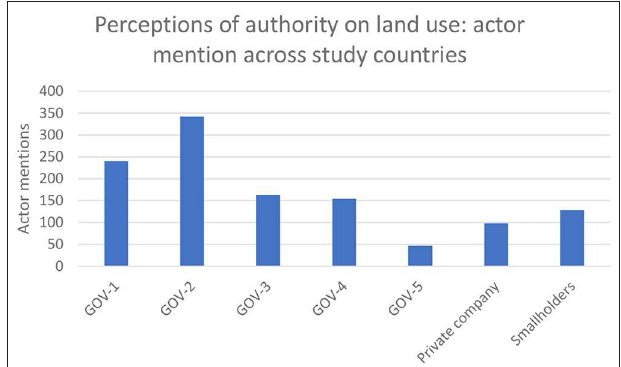
FIGURE 1 | Perceptions of authority on land use: actor mentions across study countries. GOV-1, central government authorities; GOV-2, province (Indonesia, Vietnam), region (Tanzania, Peru), or states in Mexico; GOV-3, district (Indonesia, Tanzania, Vietnam), municipality in Mexico, province in Peru; GOV-4, sub-district (Indonesia), district (Peru), ward (Tanzania), commune (Vietnam); GOV-5, Village and hamlet authorities (Indonesia, Tanzania, Vietnam), community (Peru), community or ejido government